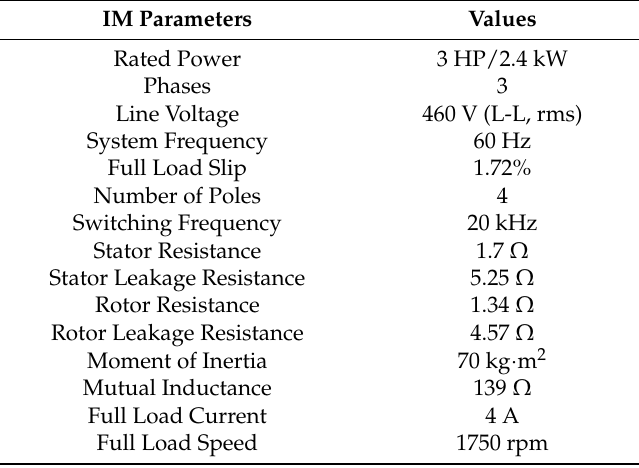
Table A1. Machine nominal